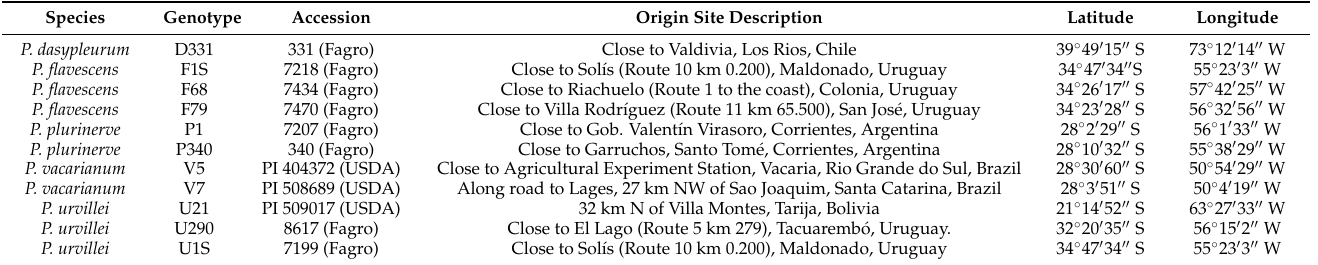
Table A3. Accessions, origin site description and location for each genotype used for germination assays.